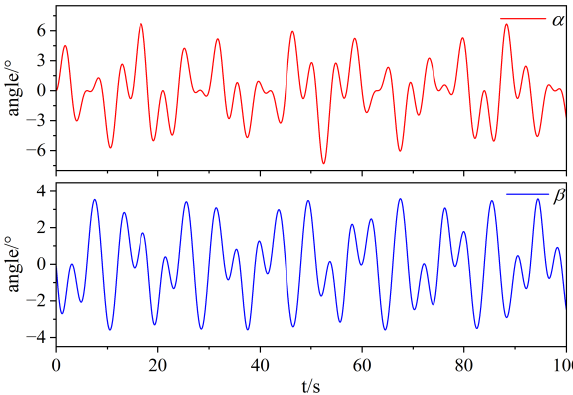
Figure 9. Curves of motion excitation.